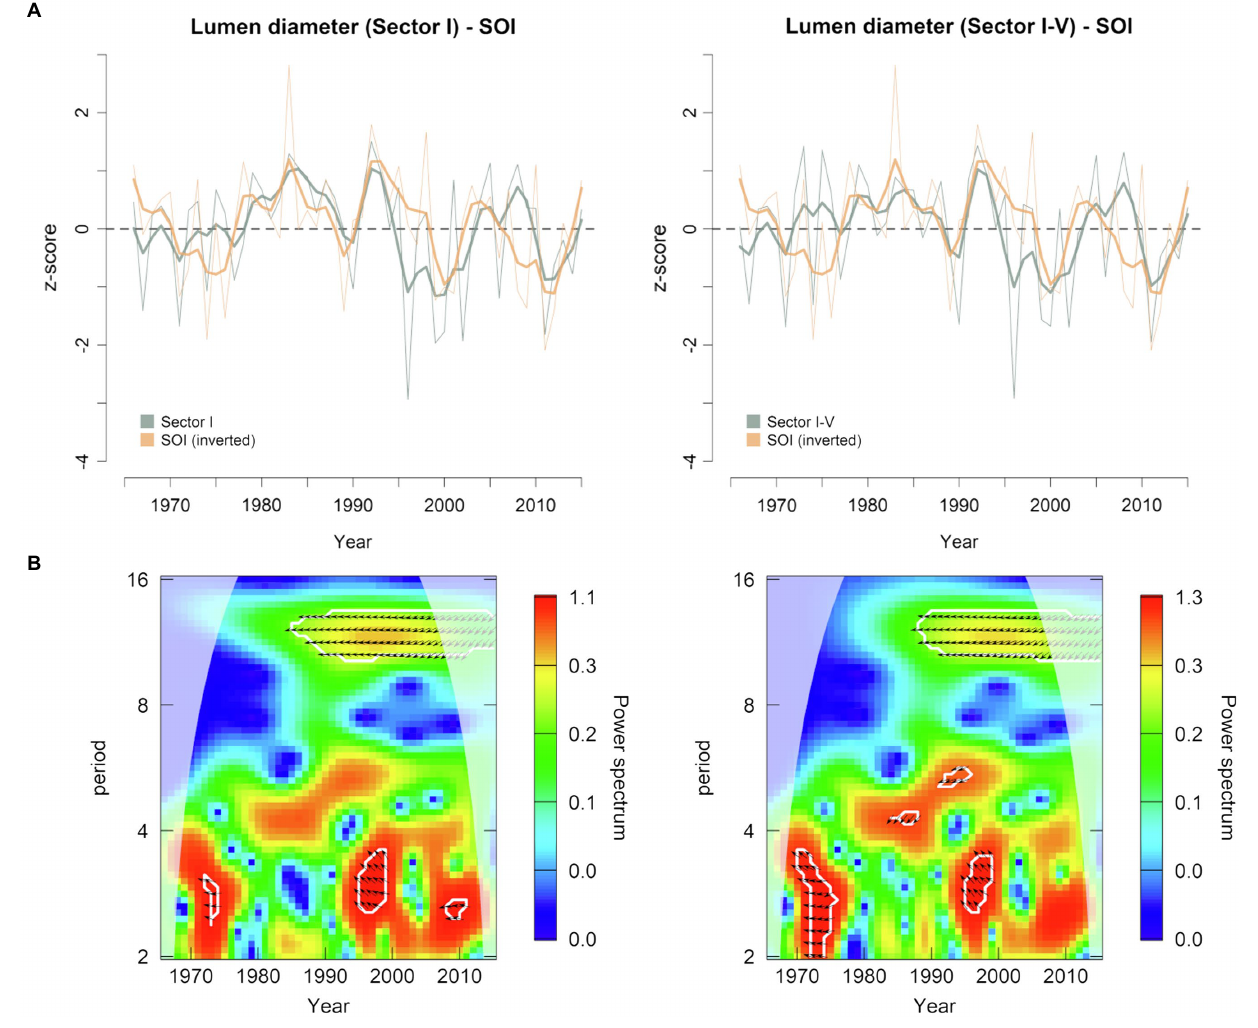
FIGURE 8 | (A) Normalized time series of earlywood lumen diameter (sectors I and I-V) plotted against previous October-current January Southern Oscillation Index (SOI) for the period 1966 to 2015 (bold lines are 5-year cubic smoothing splines). The sign of SOI has been inverted for easier interpretation. (B) Cross-wavelet transform of lumen diameter (sectors I and I-V) and SOI index. White contours represent 95% significance level. The relative phase relationship is shown as arrows (in-phase pointing right, anti-phase pointing left, and SOI leading lumen diameter by 90 ° pointing down). Results falling outside the cone of influence (white shaded area) might be distorted by edge